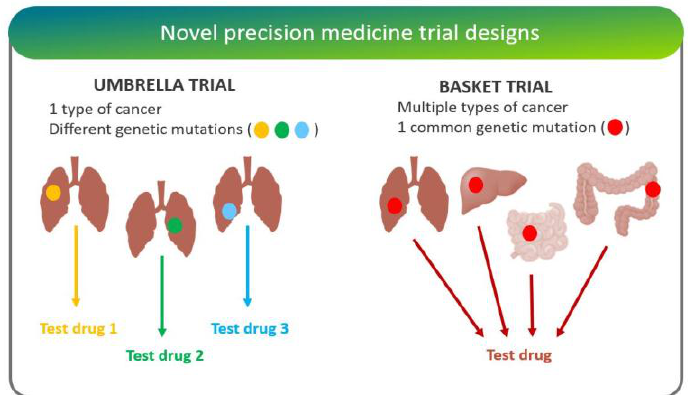
Figure 4. Depicting the core difference between “umbrella” and “basket” trial designs—figure adapted from [27]. Umbrella trials assign patients with the same type of cancer to different arms based on their mutations. Basket trials, on the other hand, test whether a drug is effective in patients with specific genetic alterations regardless of their disease of origin.